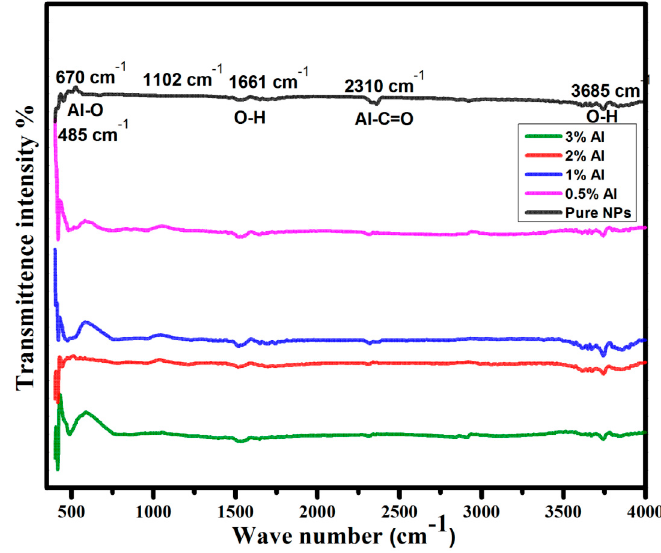
Figure 5. FTIR spectra of pure and Al doped ZnO NSs.